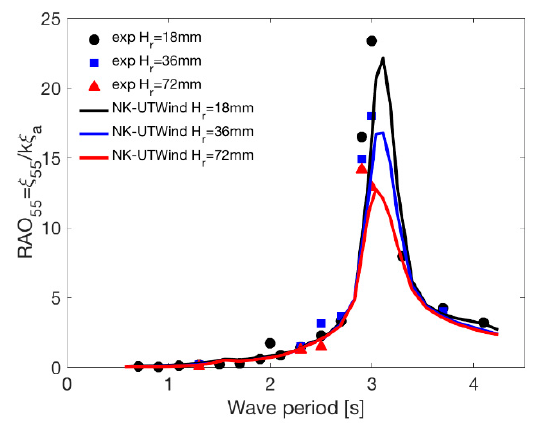
Figure 10. RAO Pitch motion result comparisons between the experiment and NK-UTWind numerical calculations for different wave heights.